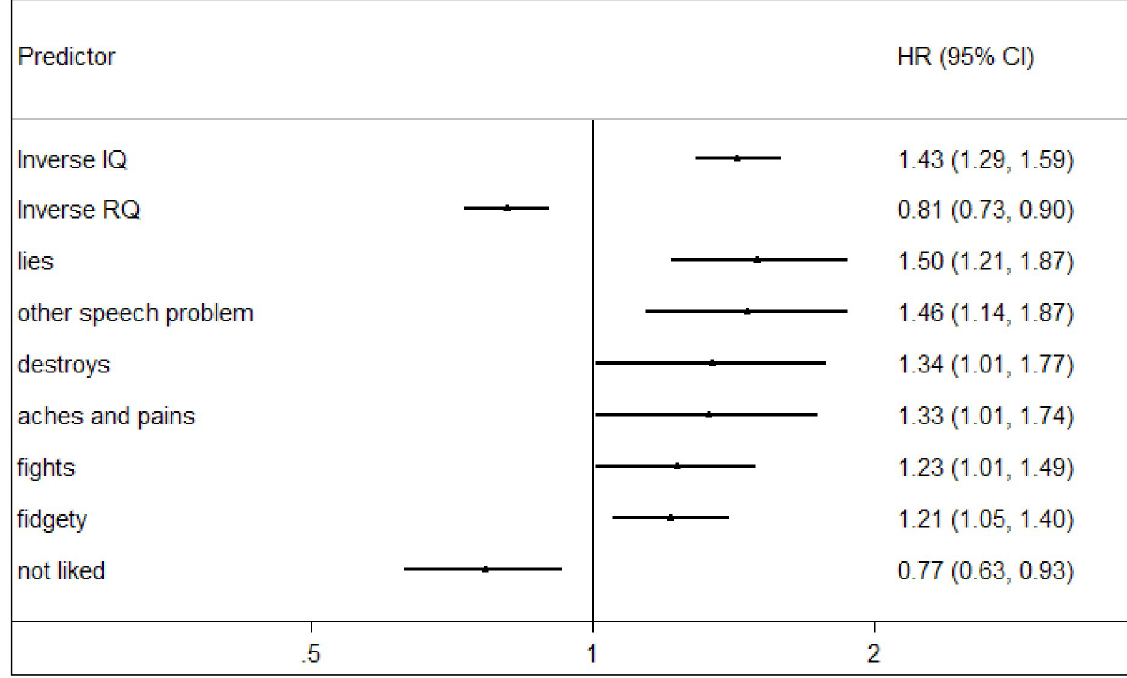
Fig 2. Selected model from analysis of Rutter B items and cognitive measures (n =